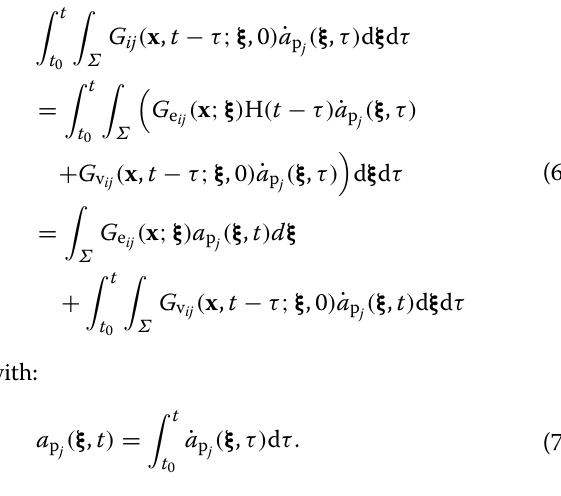
The first and second terms on the right side of Eq. (6) represent surface displacements during the postseis- mic period due to elastic and viscous responses to the cumulative postseismic slip caused from the time t 0 to the current time t , respectively. Combining Eqs. (5) and (6), Eq. (3) is rewritten as follows: